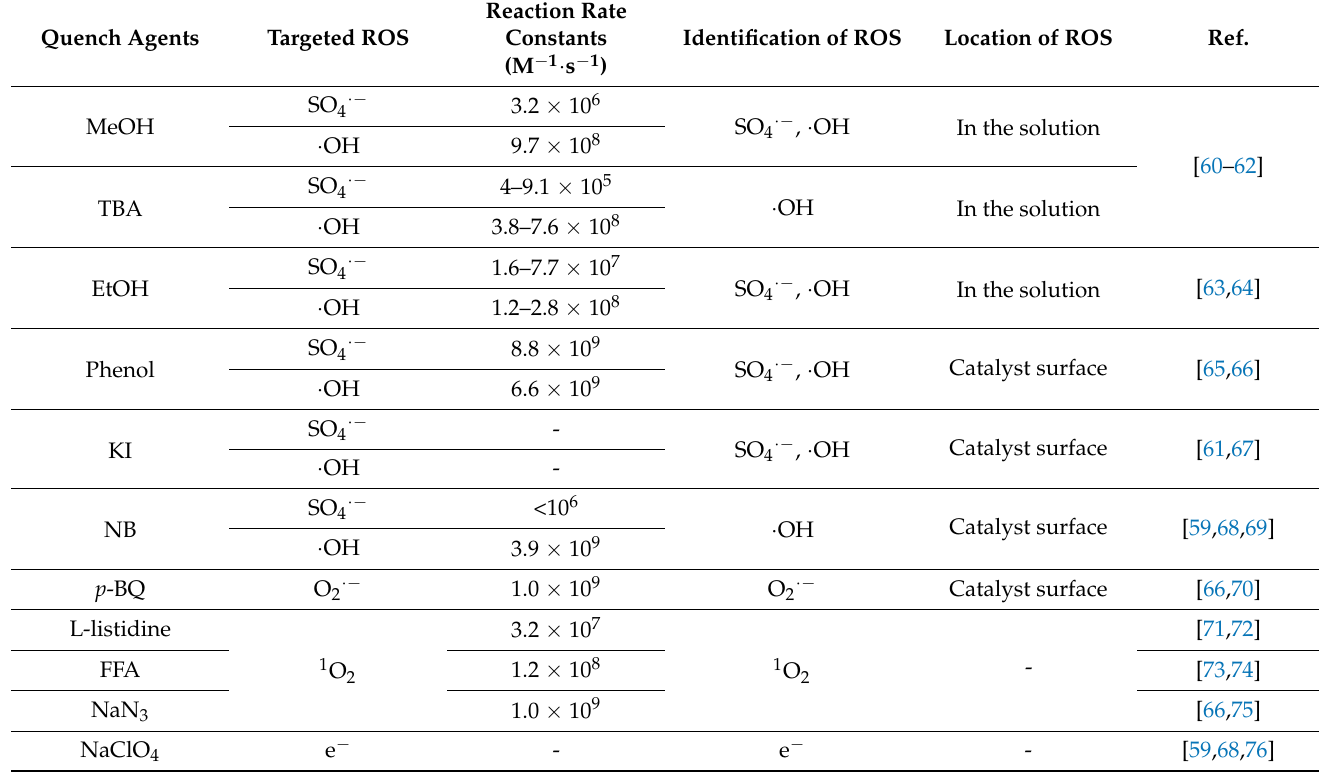
Table 1. The reaction rate constants of commonly used quenching agents with active